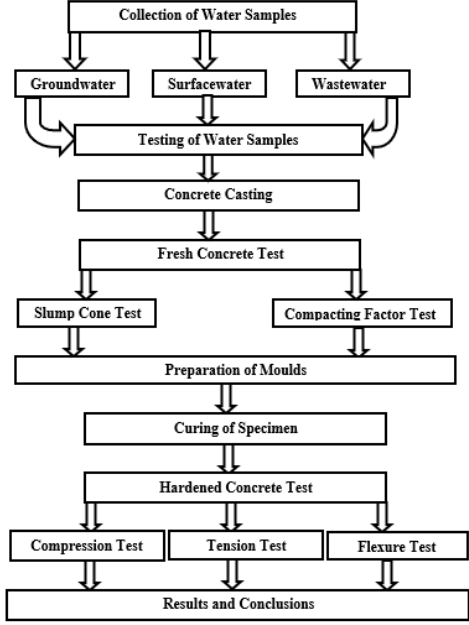
Figure 1. Methodological framework.